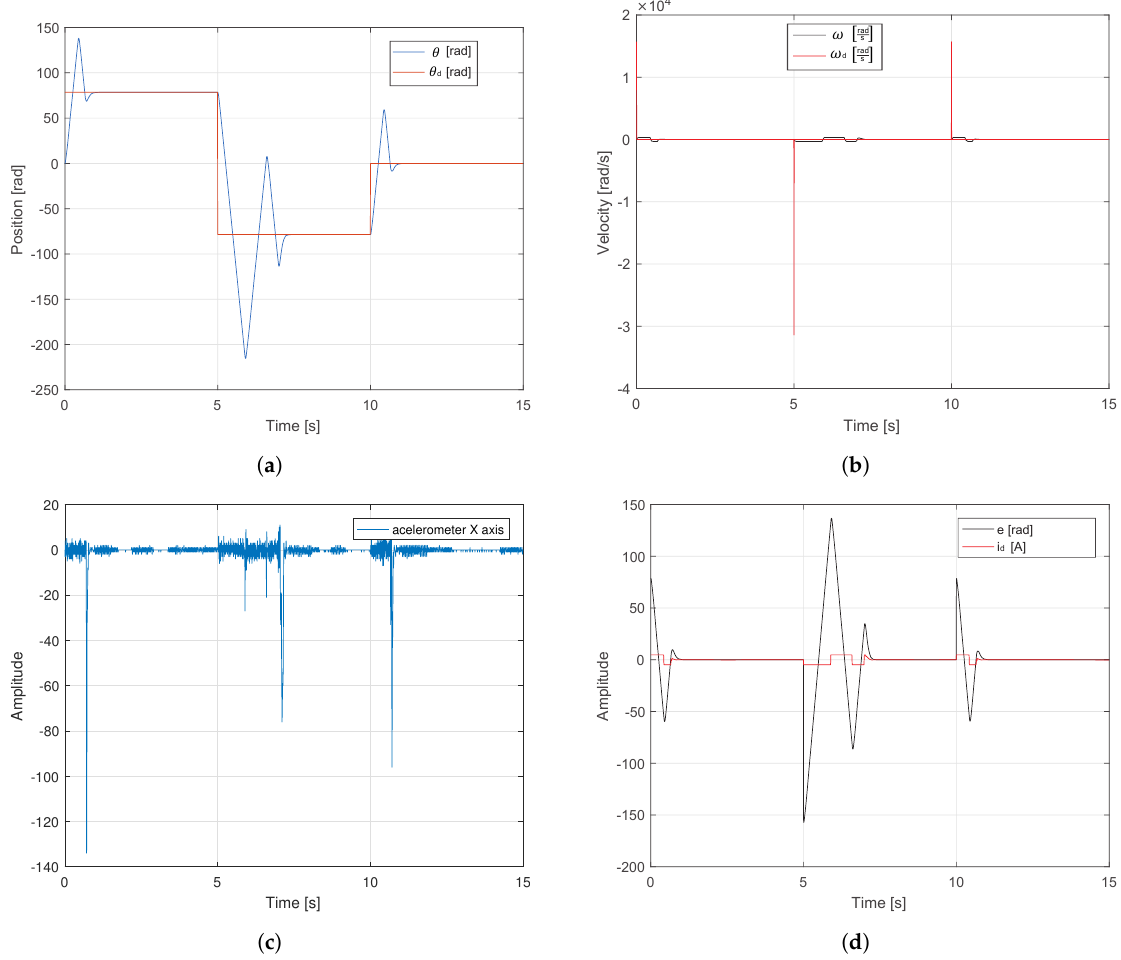
Figure 11. Response of test bench with a step input applied without GA applied. ( a ) Angular position and reference. ( b ) Angular and desired velocity. ( c ) Accelerometer X axis. ( d ) Error and control